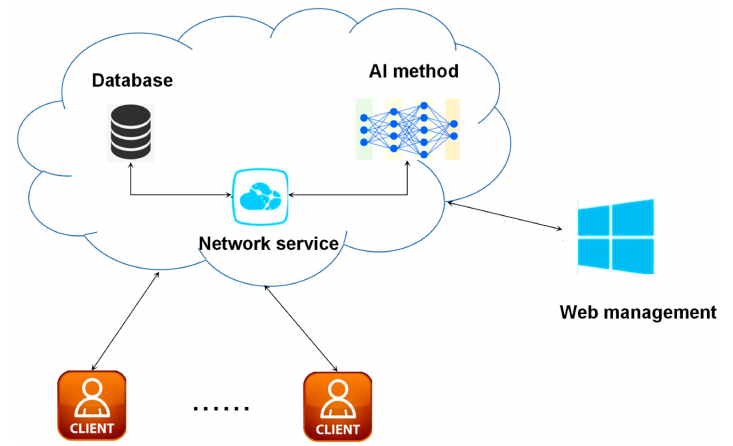
Figure 5. Framework of the cloud